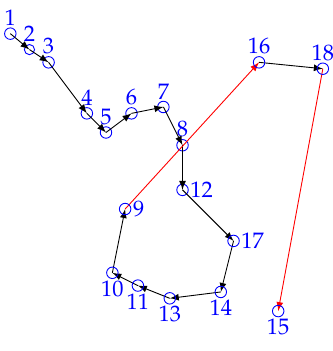
Figure 7. Long link problem.